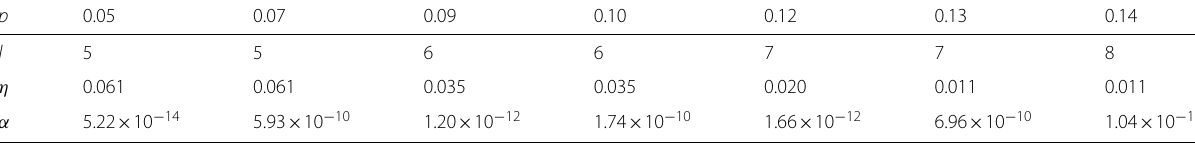
Table 2 Concatenated IR based on [ 7, 4, 3]